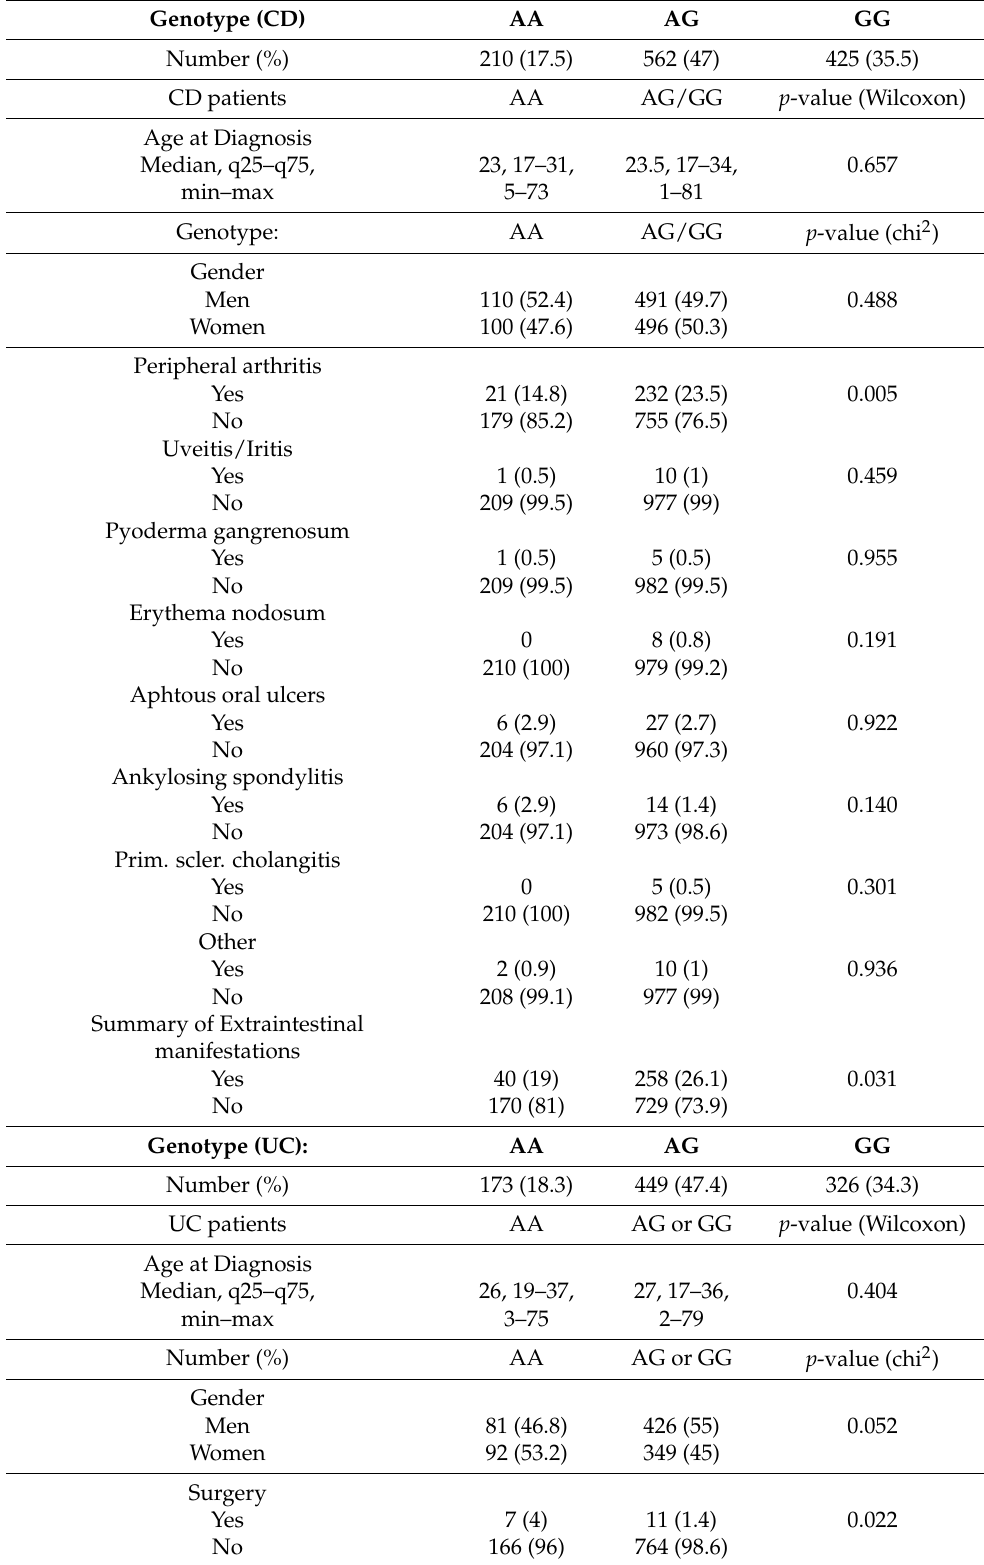
Table 1. Clinical characteristics of CD and UC patients according to presence of TPL2 risk